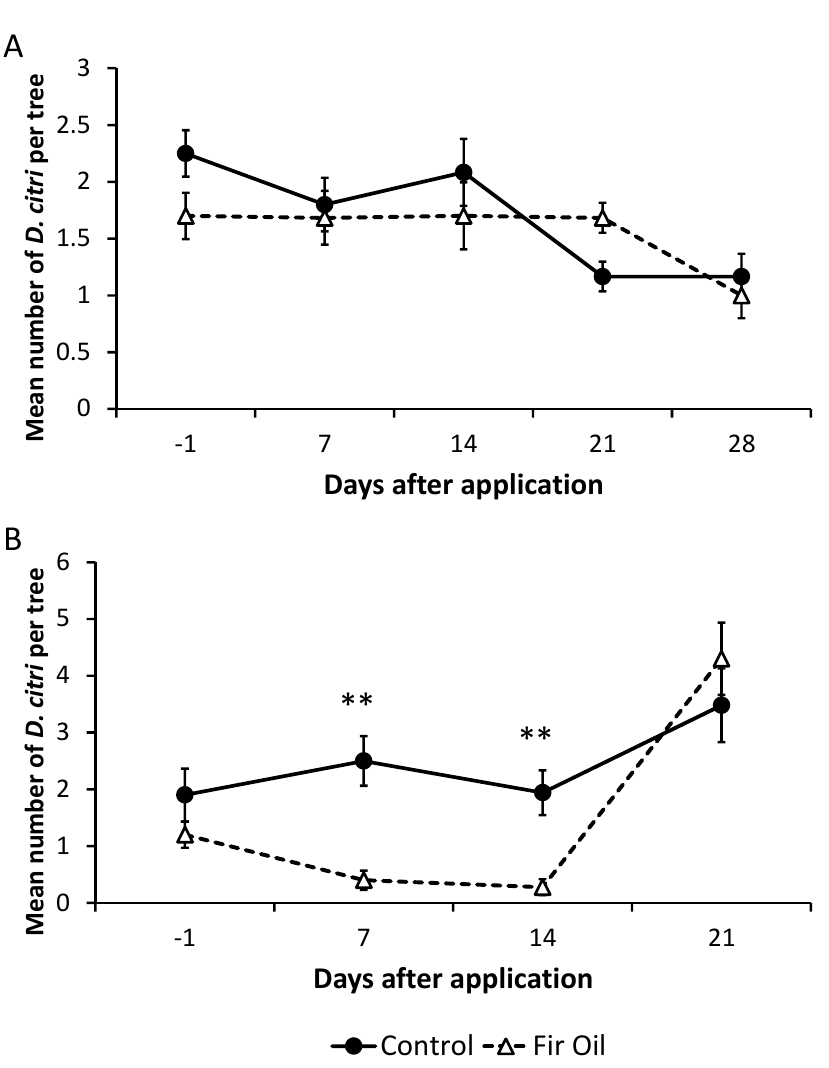
Figure 3. Mean (±SE) number of Diaphorina citri tap counted on fir oil-treated (4 dispensers/tree) vs. control plots in field trials for four weeks in 2013 ( A ) and on fir oil-treated (8 dispensers/tree) vs. control plots in field trials for three weeks in 2014 ( B ).